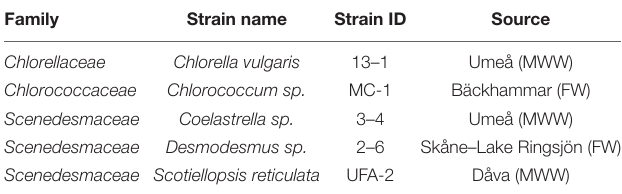
TABLE 1 | Nordic microalgal strains and their assigned strain